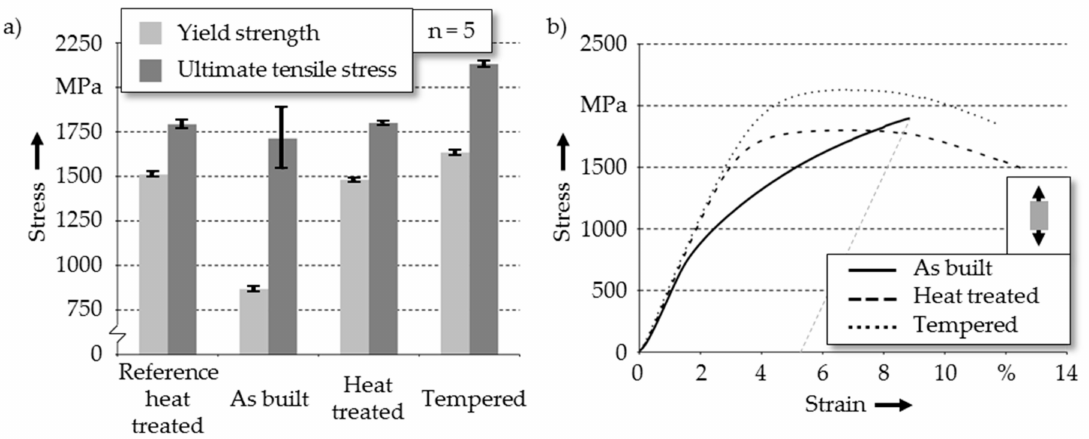
Figure 7. Results of tensile tests with an analysis of ( a ) the yield strength, and ( b ) the stress-strain curves which are exemplary of one of the specimens with different heat